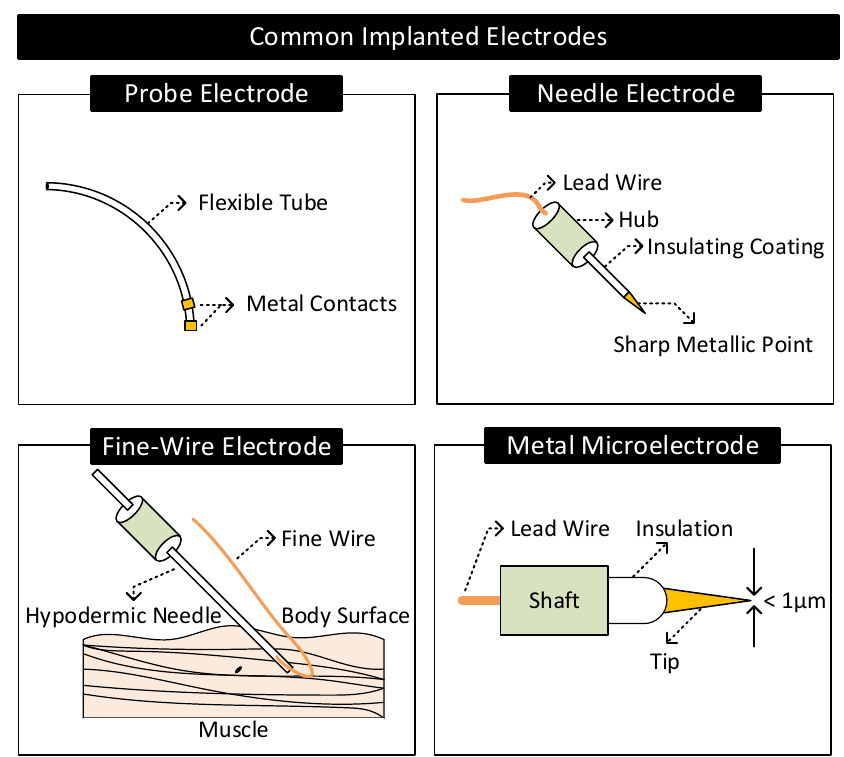
Figure 10. Common implanted